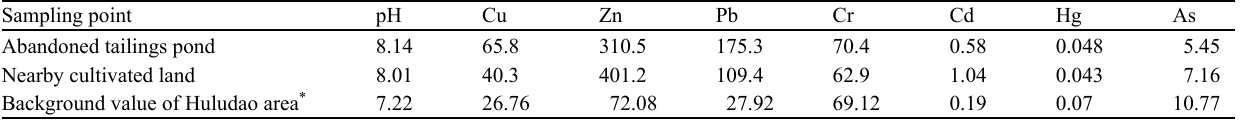
Background value of Huludao area